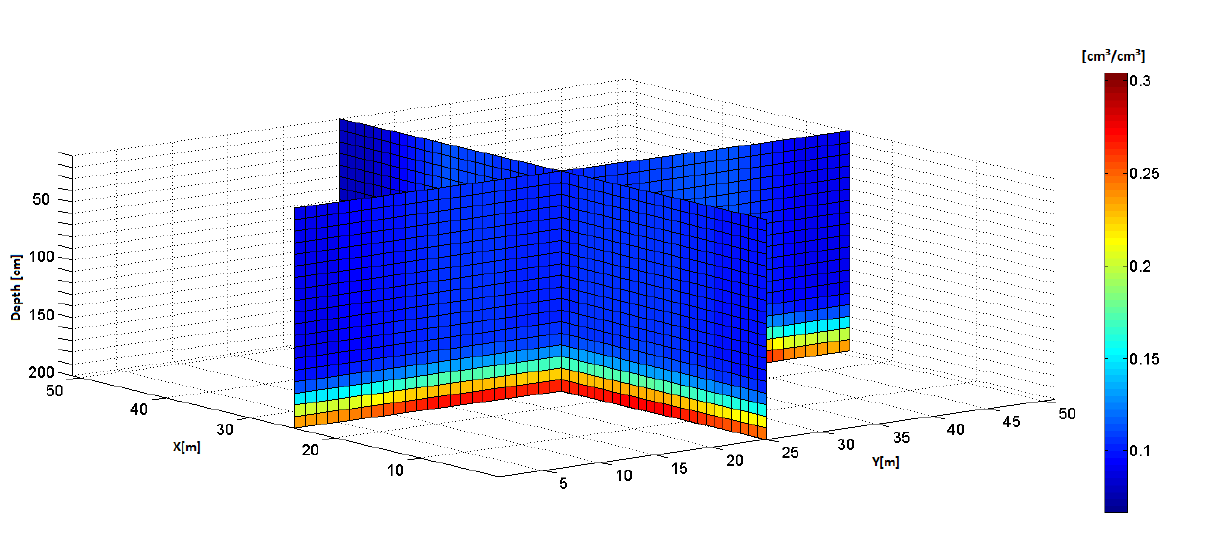
Figure 5. Water content section in sand soil